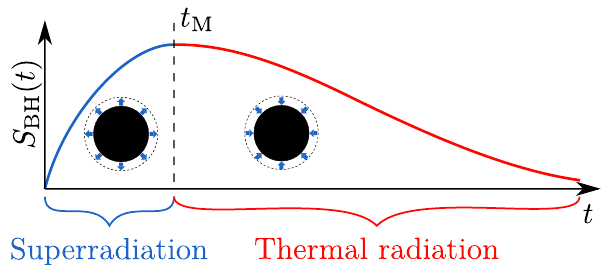
Figure 10 . At times before t M , the black hole emits mainly superradiant modes causing it to heat up. After t , thermal Hawking emission dominates, the black hole loses energy, and the system M dissipates completely. The curve in this figure is specific for E jump at t = 0